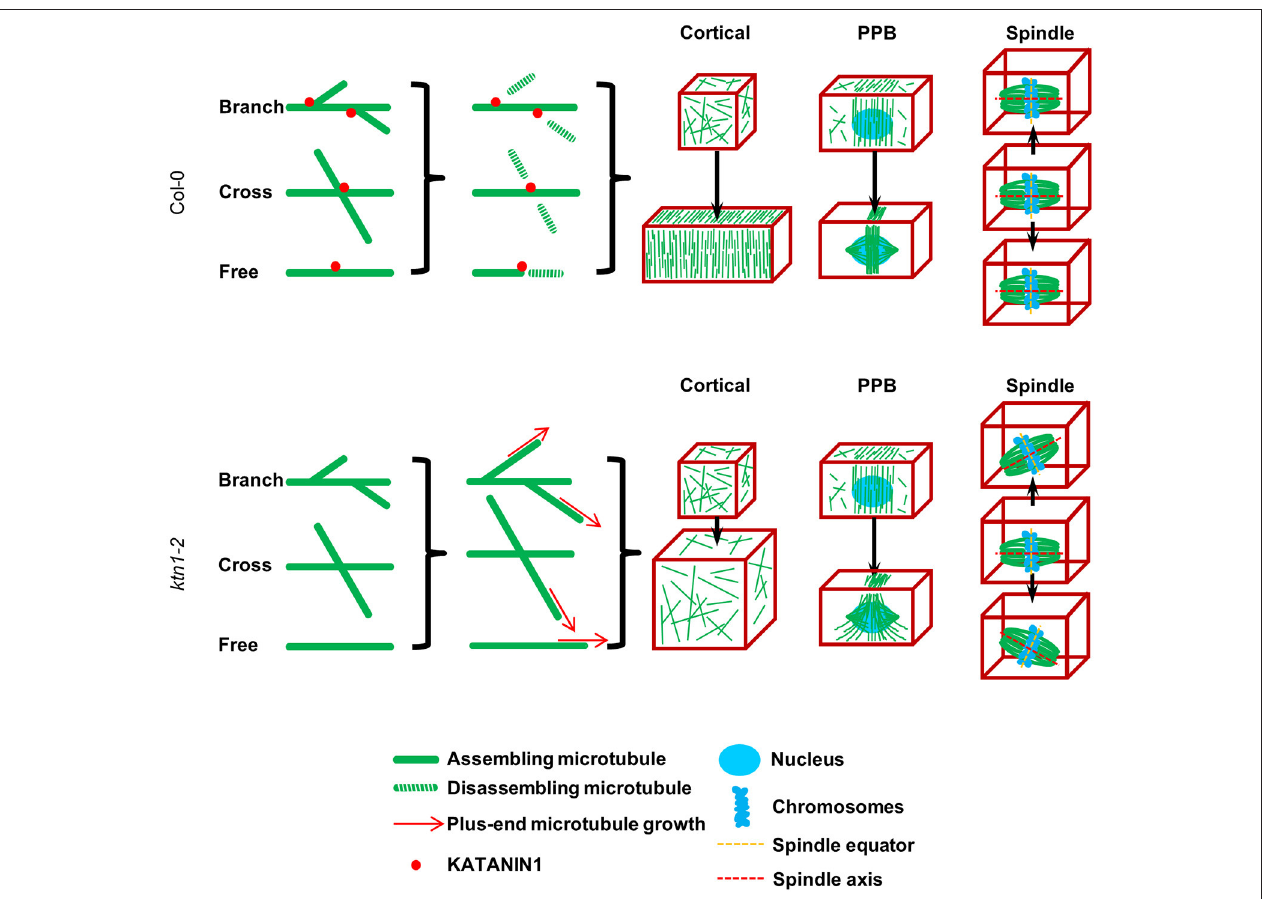
FIGURE 11 | A simplified schematic model explaining the defects of KATANIN 1 depletion in cell growth, PPB formation, and mitotic spindle positioning according to published and present data. KATANIN 1 severs microtubules after branched formation ( Nakamura et al., 2010), at microtubule crossovers (Wightman and Turner, 2007) apart from severing free microtubules. Through its activity, KATANIN 1 promotes the biased organization of microtubules at different stages of plant cell cycle. In interphase cells, KATANIN 1 microtubule severing induces parallel arrangement of cortical microtubules and supports unidirectional cell growth while in its absence as it occurs in ktn1-2 mutant, cortical microtubule arrays remain disordered and result in isotropic cell growth. During PPB formation, KATANIN 1 severing activity promotes microtubule organization and confinement to the PPB zone while it is implicated in PPB narrowing. PPB formation and its course of maturation are impaired in ktn1-2 . Finally, during mitosis, KATANIN 1 activity is related to mitotic spindle positioning by securing co-alignment of the equatorial plane with the CDP without affecting spindle formation, while in its absence the spindle exhibits considerable motions and appears to freely rotate in the cytoplasm. This model differs from that of Panteris et al. (2011) in that it appoints spindle rotation in KATANIN 1 mutants such as ktn1-2 to a continuous dynamic process rather than attributing it to structural deficits caused during spindle formation (spindle